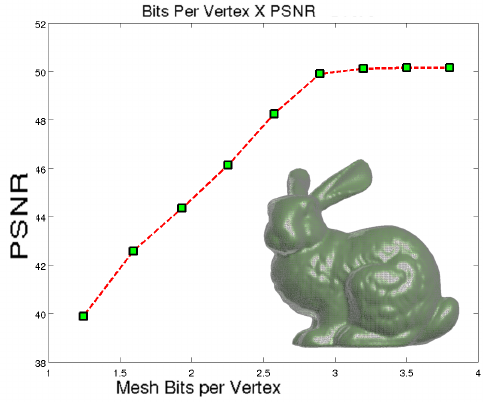
Figure 16: PSNR error depending on the compression rate (BPV) to the Bunny